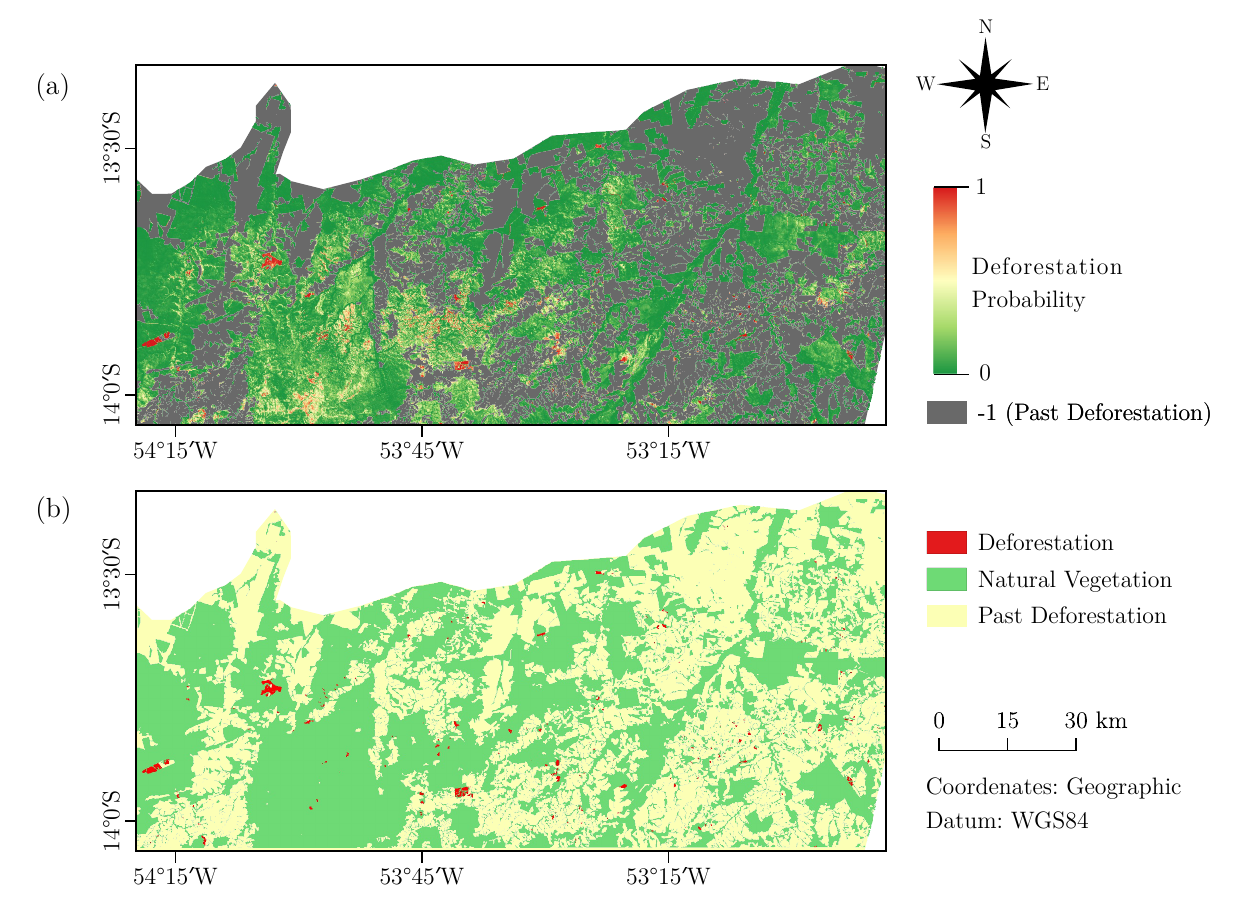
Figure 6. Results for Mato Grosso study area, Landsat time series and training samples based on Approach 3. ( a ) LSTM deforestation probability map; ( b ) U-Net deforestation